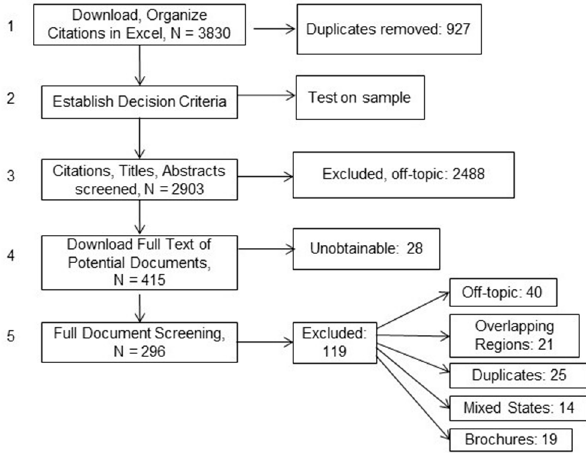
Figure 2. Summary of steps in document search and review sequence.